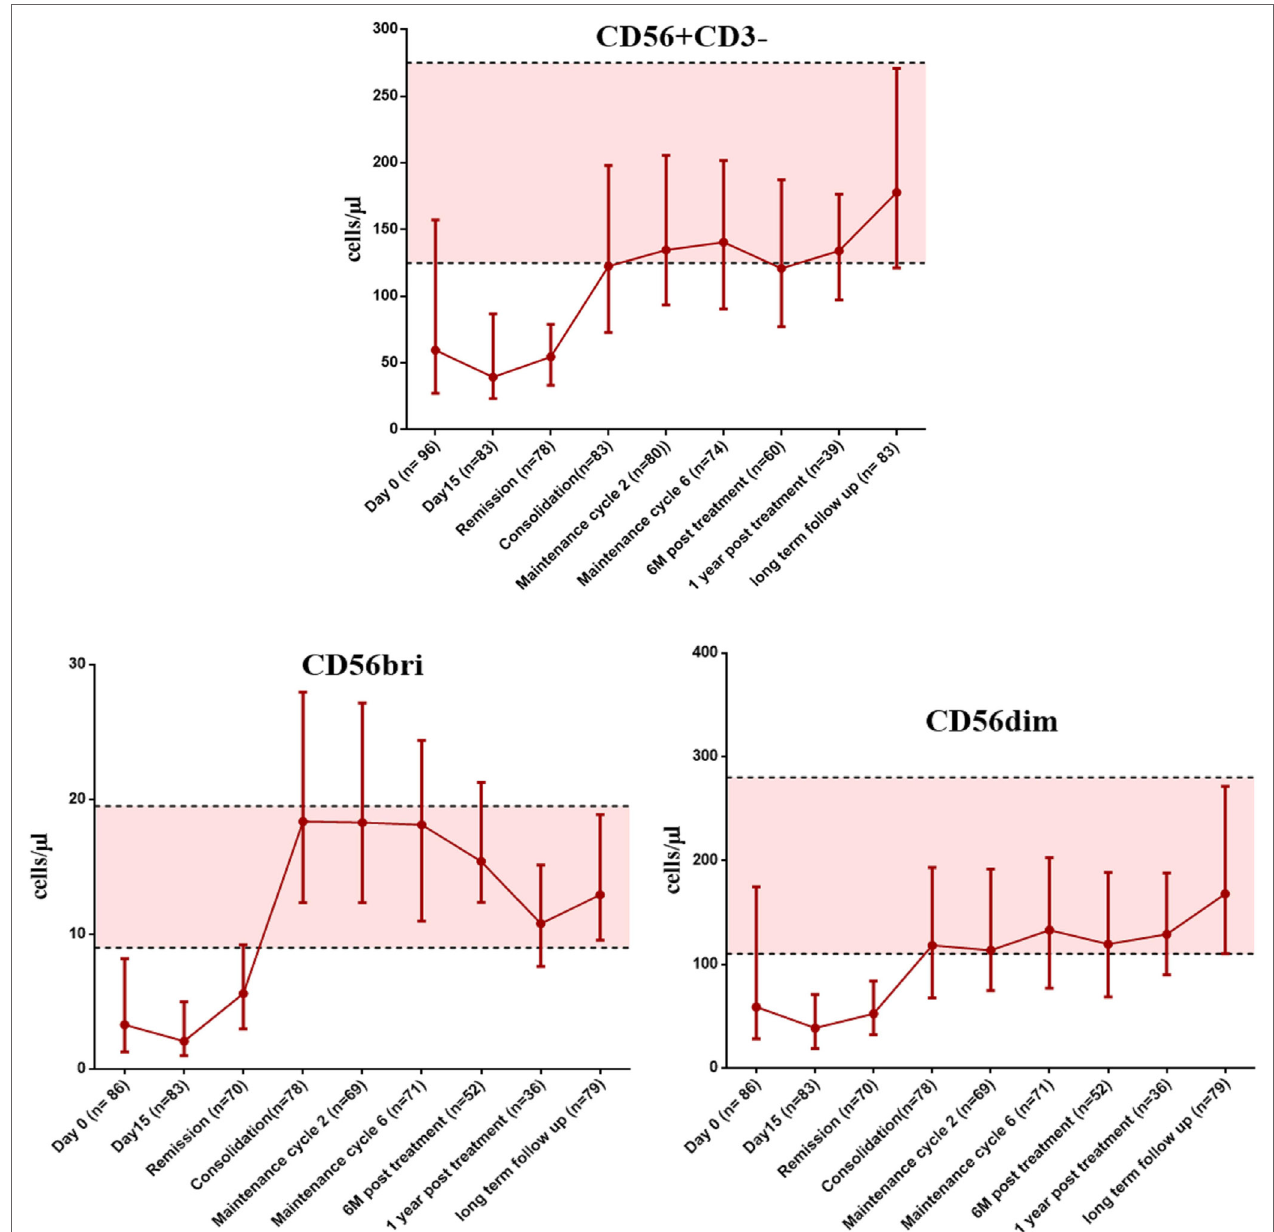
FigUre 6 | The graphs showing the recovery of NK cells and it subsets (CD56 bright and CD56 dim ) at appropriate time points post treatment with arsenic trioxide. The error bars indicate median with interquartile ranges. The shaded region represents the 25th to 75th percentile values of very long term follow-up samples serve as normal reference ranges. Number of samples available at each time points were mentioned in brackets. The time points of samples collected were mentioned on X axis. Absolute counts were given as cells per microliter on Y